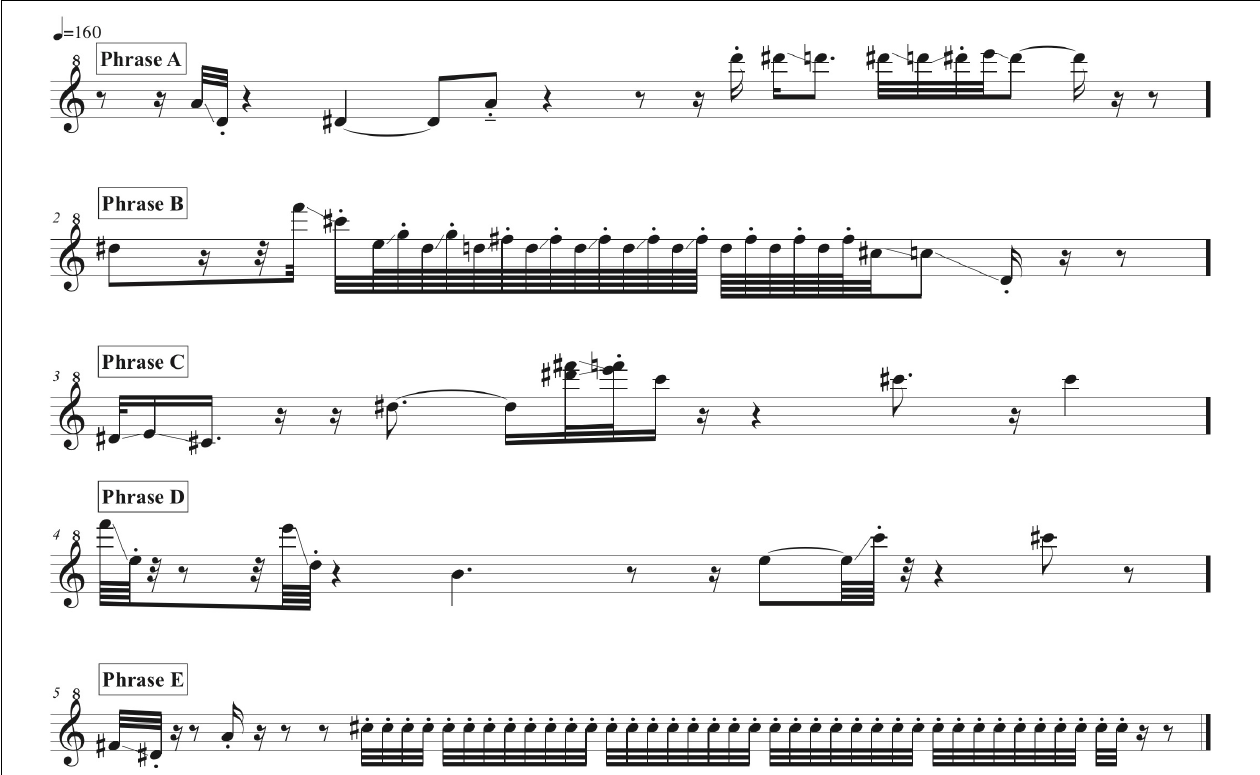
FIGURE 7 | A music transcription of phrases A, B, C, D, and E as delivered by the adult bird as summarized in Supplementary Audio 3 . # Means sharp in music